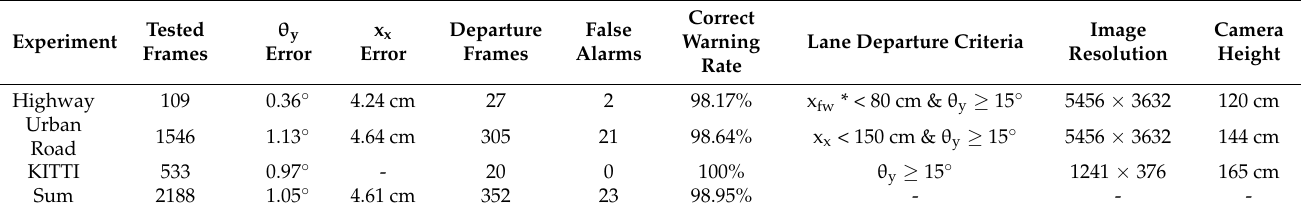
Table 1. The experimental results for lane departure assessment.